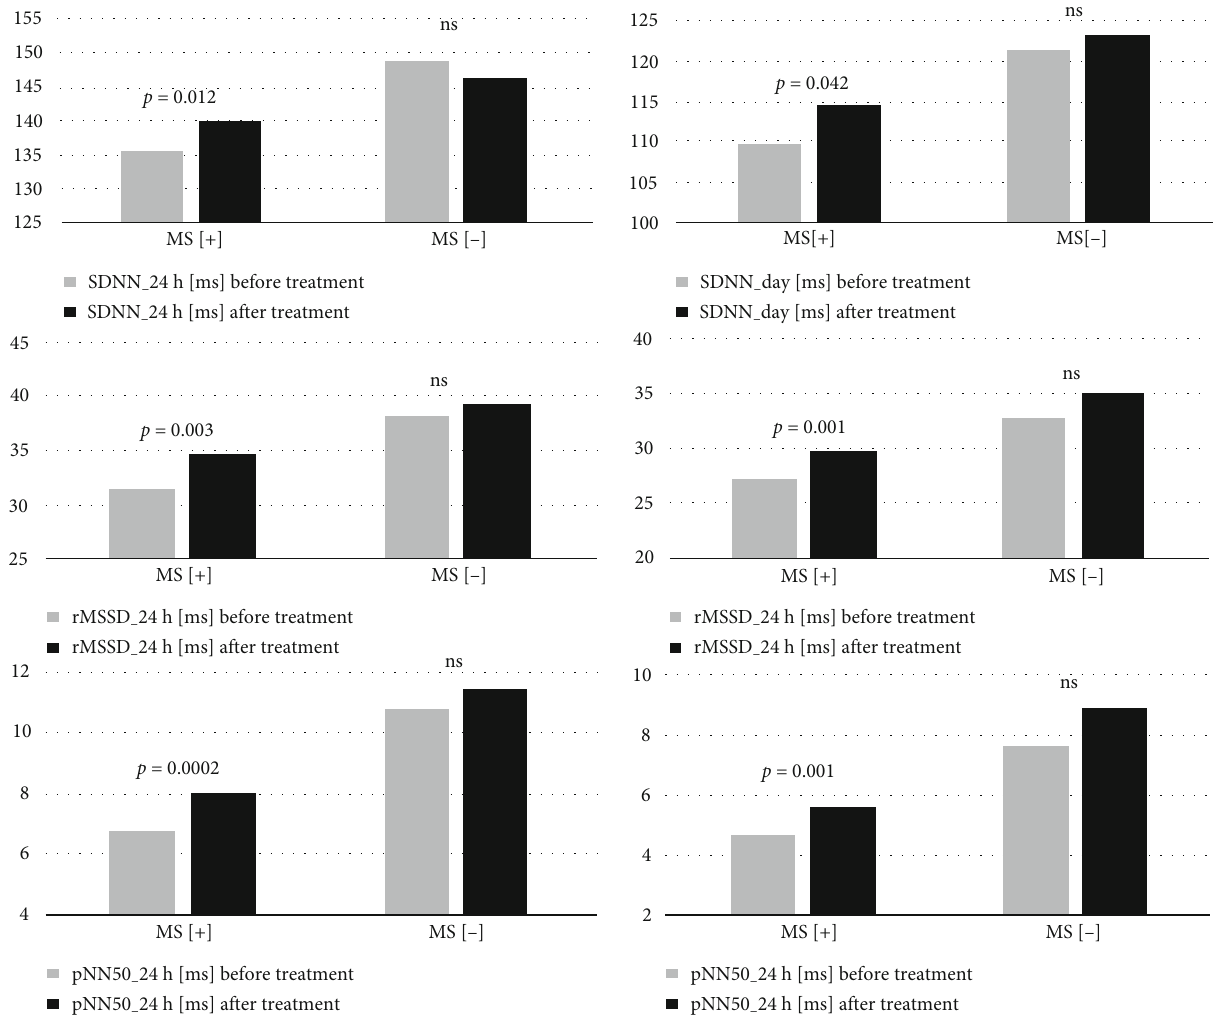
Figure 2: Comparison of selected HRV parameters before and after 12-month treatment, in patients with HTN strati fi ed by concomitant